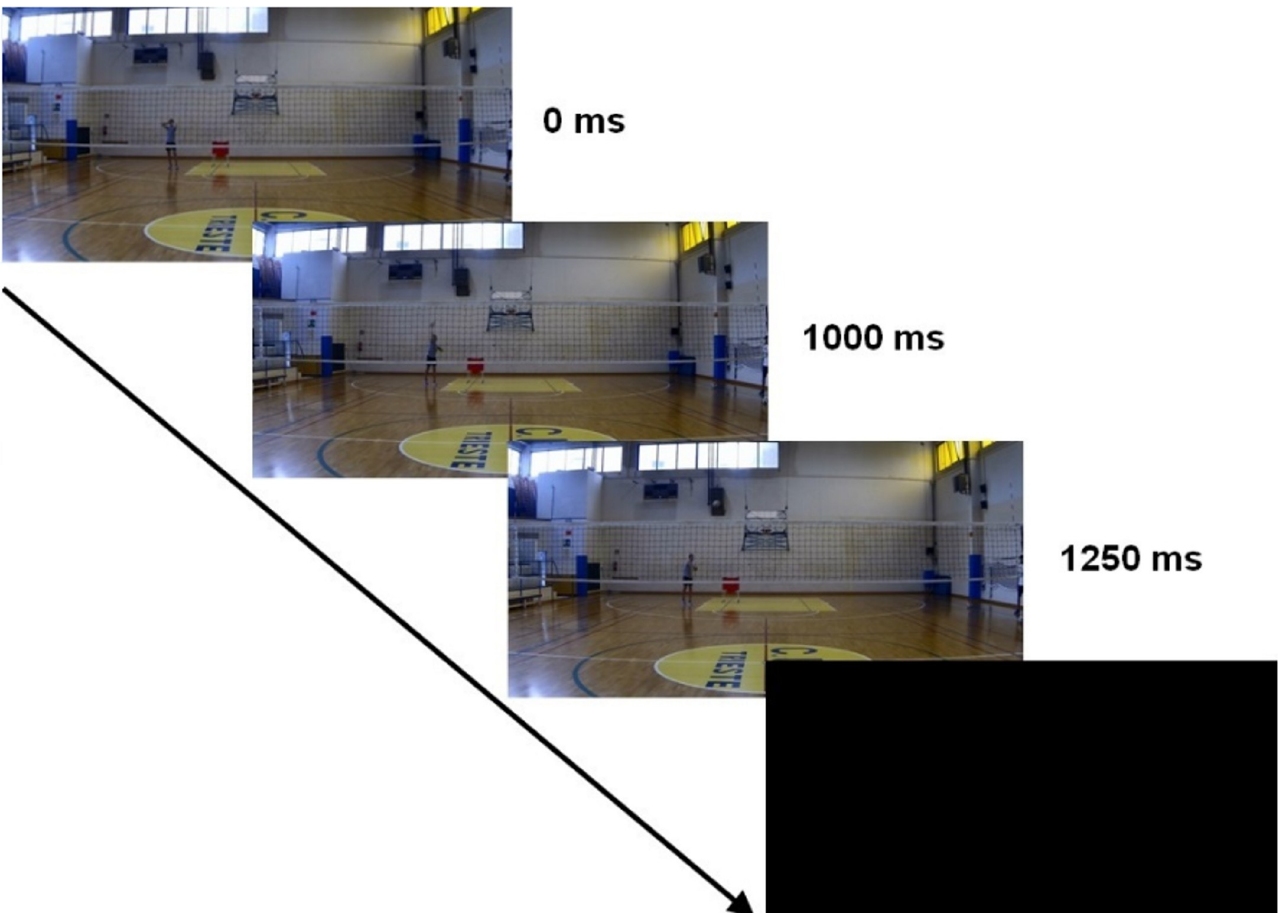
Fig 2. The visual part of a prototypical stimulus. The audio was synchronized with the video, and they were either congruent or incongruent between them as concerns the length of the